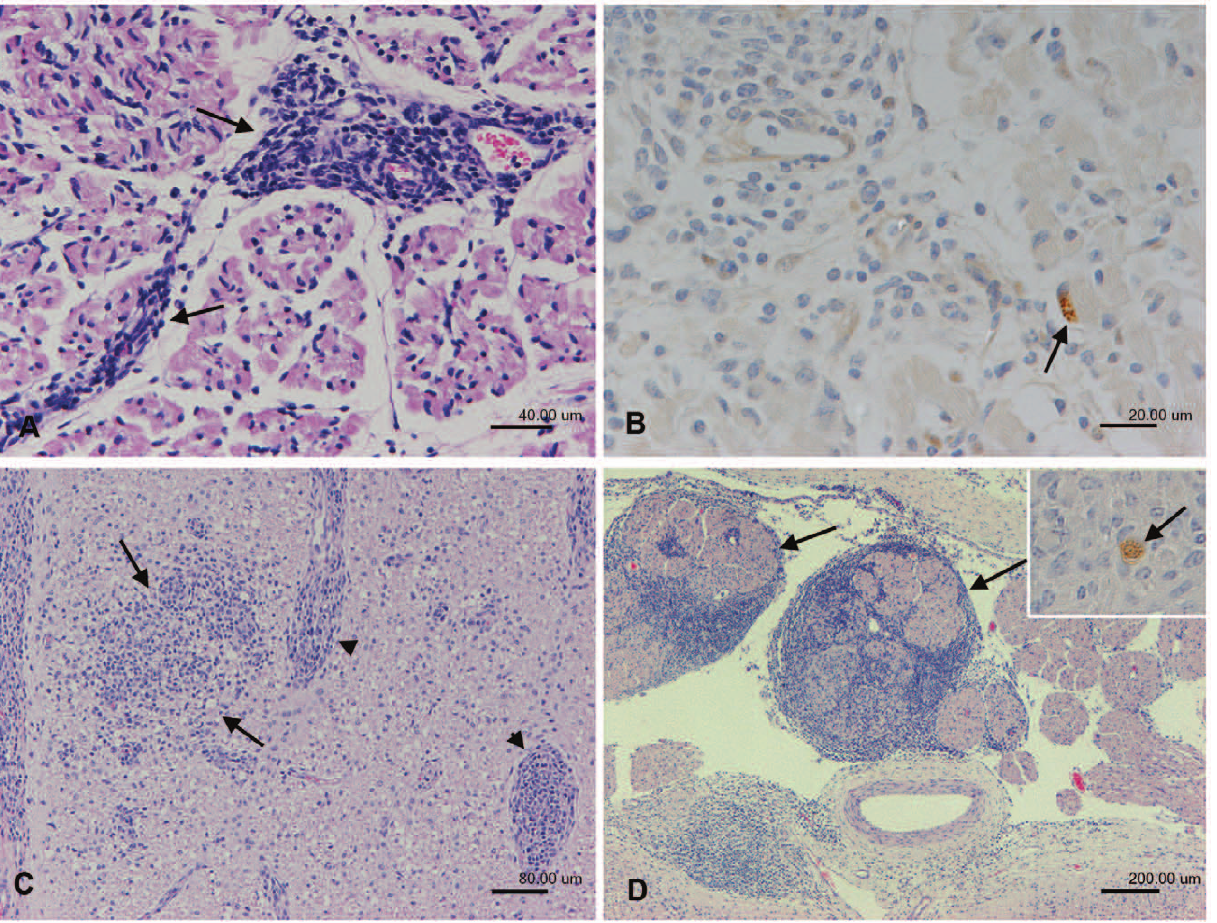
Figure 4. Histology and immunohistology of foetal tissues after parasite recrudescence. Foetus after parasite recrudescence. A, B. Foetus from animal no. 2, 25 weeks of gestation, skeletal muscle. A. Focal interstitial mononuclear (lymphocytes, plasma cells, macrophages) infiltration is seen (arrow; non-suppurative myosistis). B. Neospora antigen is seen within an intact myocyte immediately adjacent to the inflammatory infiltrate (arrow). C, D. Foetus from animal 6, 32 weeks of gestation. C. Spinal cord, exhibiting a moderate, focal extensive non-suppurative myelitis, represented by focal parenchymal (arrows) and perivascular (arrowheads) mononuclear inflammatory infiltrates. D. Dorsal root, spinal cord. Severe non-suppurative (mononuclear) radioculoneuritis (arrows). Inset: Staining for Neospora antigen identifies small extracellular cluster of tachyzoites within the inflammatory infiltrate (arrow). A, C, D. Haematoxylin-eosin stain. B, Inset D. Peroxidase anti-peroxidase method. Papanicolaou’s haematoxylin counterstain.